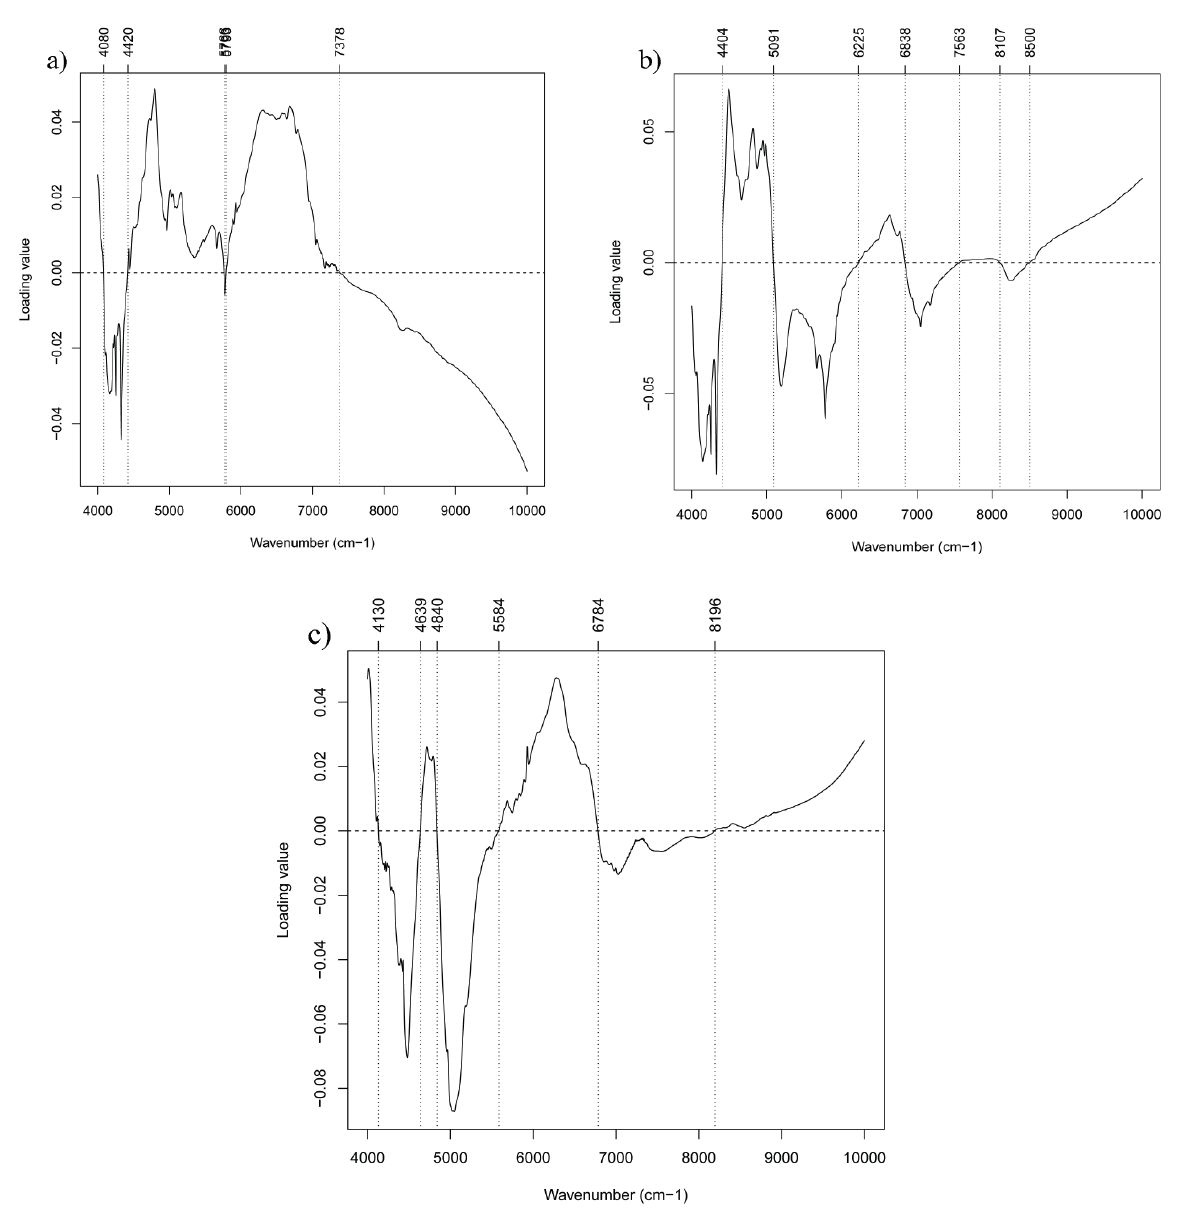
Figure 10 : Loading values of the first (a), the second (b) and the third (c) PCs of the NIR